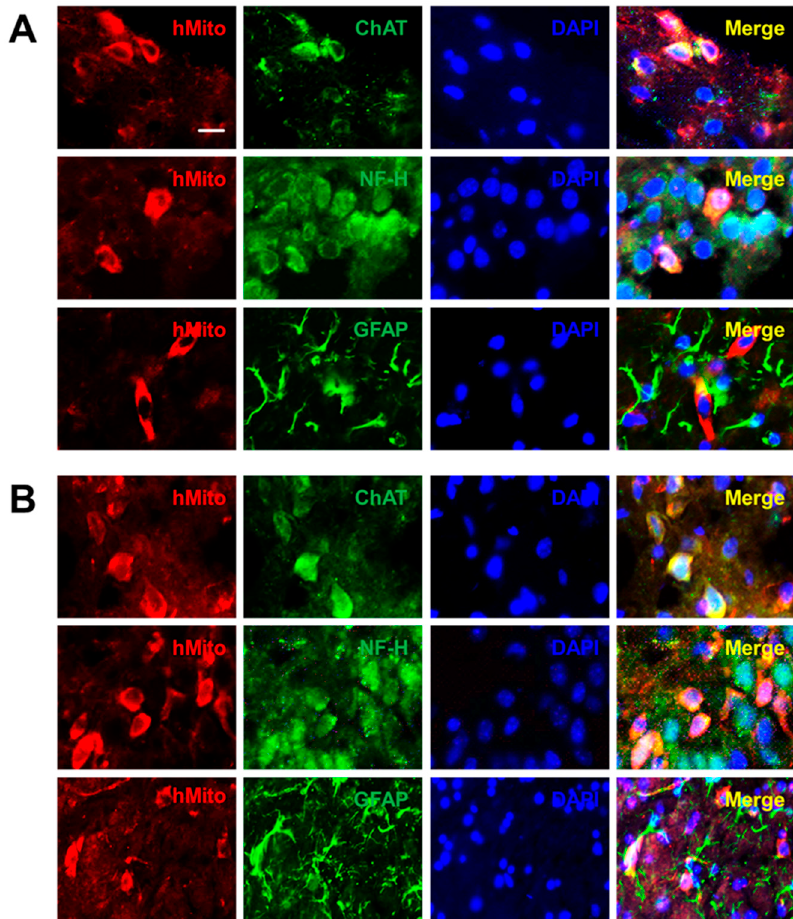
Figure 1. Representative immunohistochemical findings on the differentiation and production of functional protein (ChAT) of transplanted neural stem cells (NSCs). Differentiation of human mitochondria (hMito)-positive F3 (( A ): Group 3) and F3 NSC line overexpressing ChAT gene (F3.ChAT) (( B ): Group 4) into neurons (NF-H-positive) and astrocytes (GFAP-positive), and ChAT production were analyzed by double immunostaining in the hippocampus of APPswe/PS1dE9 transgenic mice. GFAP: glial fibrillary acidic proteins. Bar = 10 μ m.